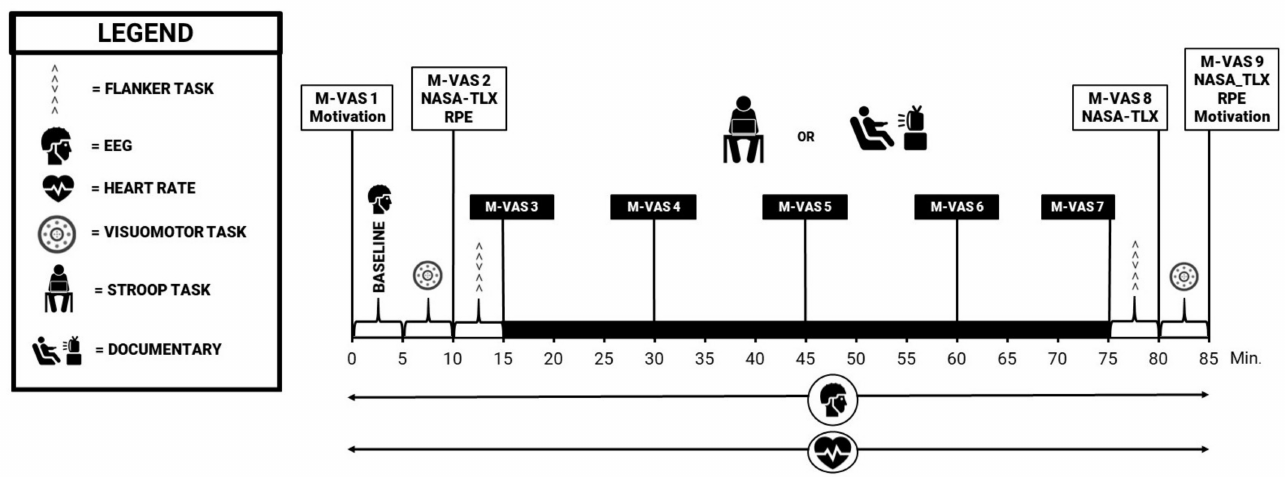
Figure 1. Schematic representation of the experimental and control trial. Flanker task: Participants were instructed to respond as quickly and accurately as possible to the direction of a target arrow while ignoring the direction of the other arrows on each side (e.g., < < > < <). Each array of arrows was focally presented in white text (font size 34) for 200 ms on a black background with a variable interstimulus interval of 1000, 1200, 1400, or 1600 ms. A total of 120 stimuli were given (15 cycles of 8 stimuli) with both right and left arrows appearing with equal probability. The total duration of the task was approximately 5 min. To assess performance on the flanker task accuracy and reaction time were collected. The aim of the flanker task was to make sure that participants were adequately familiarized and not already fatigued before the start of the intervention/control task